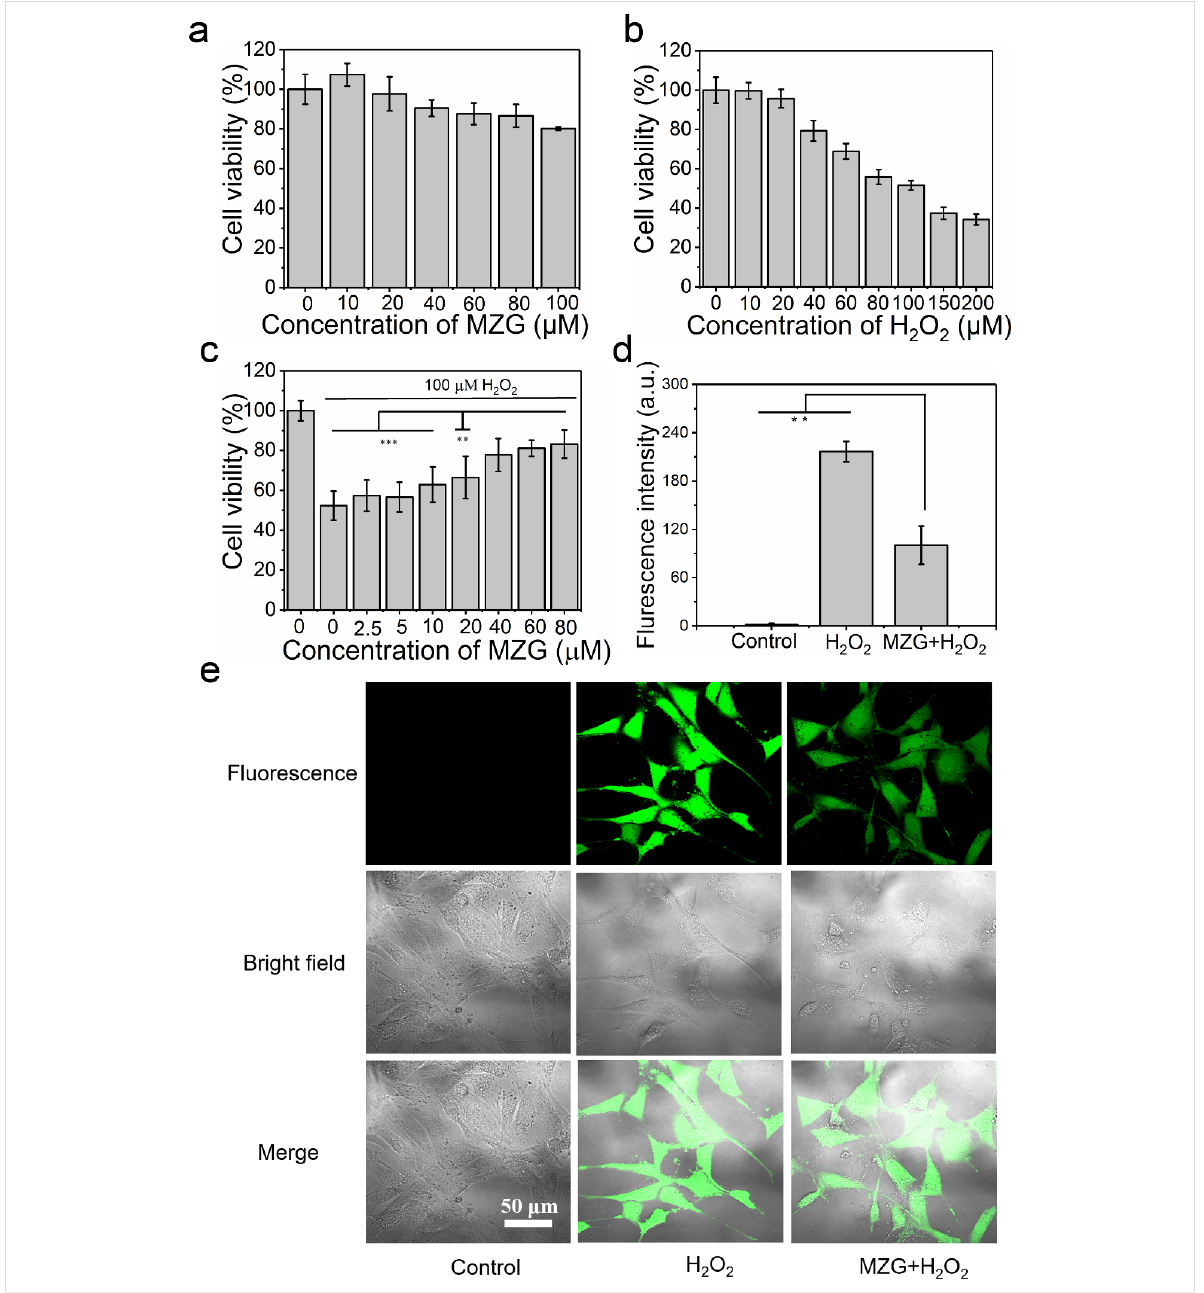
Figure 4: Antioxidant activity evaluation in cells. (a) Cytotoxicity evaluation of MZG nanoparticles by incubating 3T3 cells with different concentrations of MZG nanoparticles (equivalent concentration of Myr: 10, 20, 40, 80, and 100 µM). (b) H 2 O 2 -induced oxidative stress by incubating 3T3 cells with different concentrations of H 2 O 2 . (c) Antioxidant activity evaluation of MZG nanoparticles using 3T3 cells under H 2 O 2 -induced oxidative stress (** indi- cates p < 0.01, *** indicates p < 0.001). (d) Fluorescence intensity of ROS probed by DCFH-DA in cells after incubating with H 2 O 2 and a combination of MZG nanoparticles and H 2 O 2 (** indicates p < 0.01). (e) CLSM images of 3T3 cells probed by DCFH-DA after incubating with MZG nanoparticles and